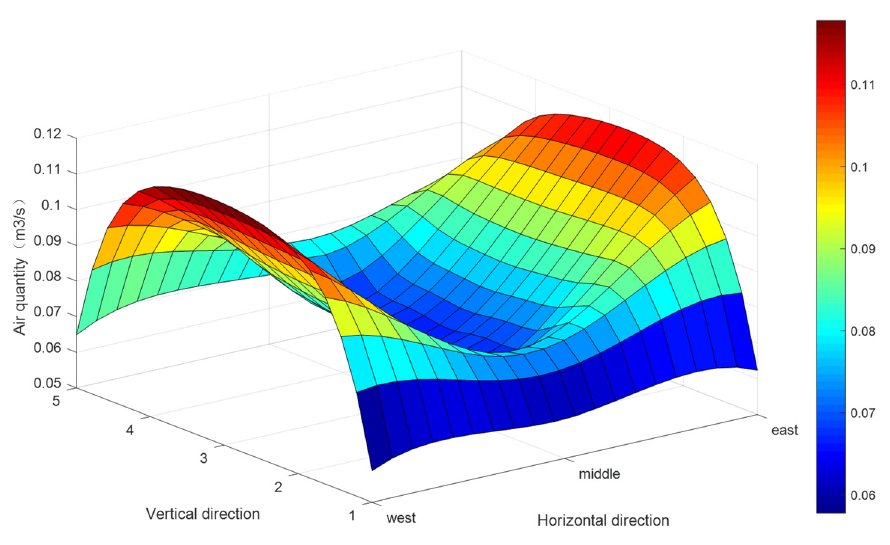
Figure 18. Ventilation quantity in summer.